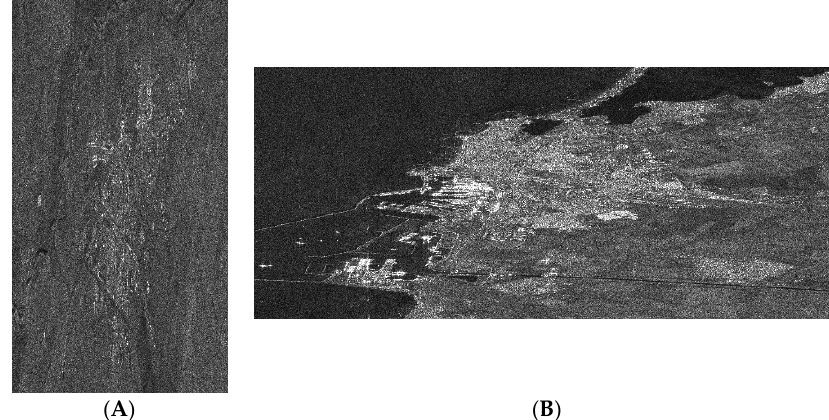
Figure 4. Amplitude of European Remote Sensing (ERS) dataset’s master image, Buzău region. Acquisition date: 11 August 1997 ( A ). Amplitude of Sentinel-1 dataset’s master image, Constanta region. Acquisition date: 20 November 2015 ( B ).